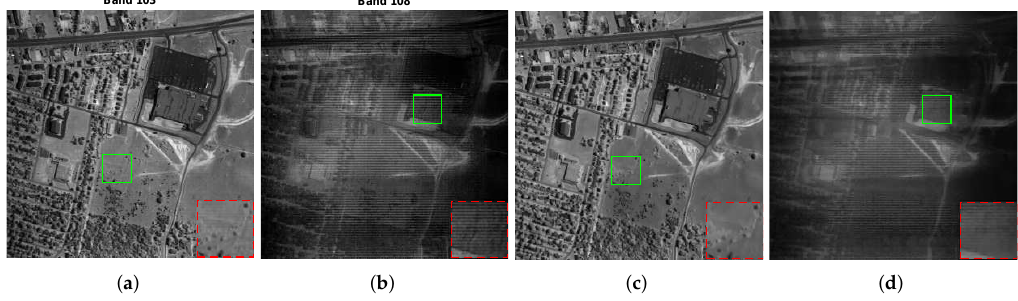
Figure 2. Images of band 103 and 108 of the restoration results in Urban dataset. ( a , b ) LRMR; ( c , d ) LRTV. (Zoom in to see the details